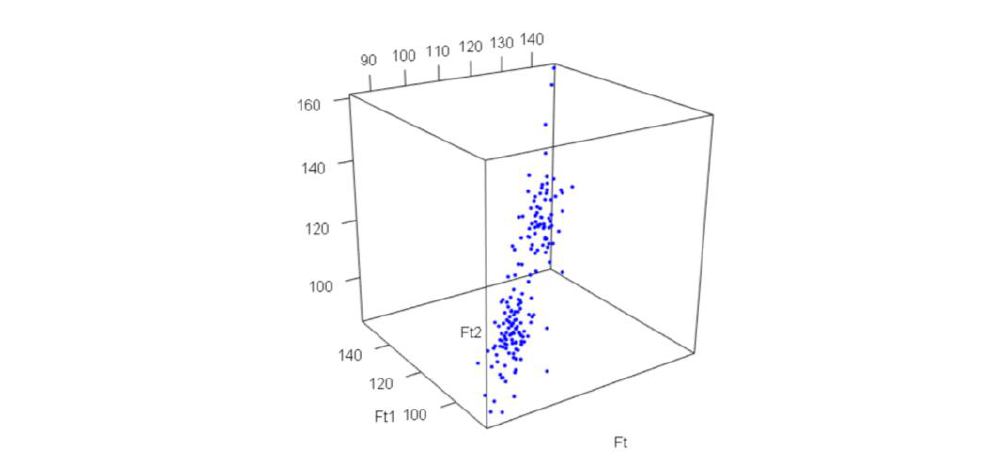
Figure 1: Multiple equilibria in 3-d embedding space of global food index time evolution; Source: Author